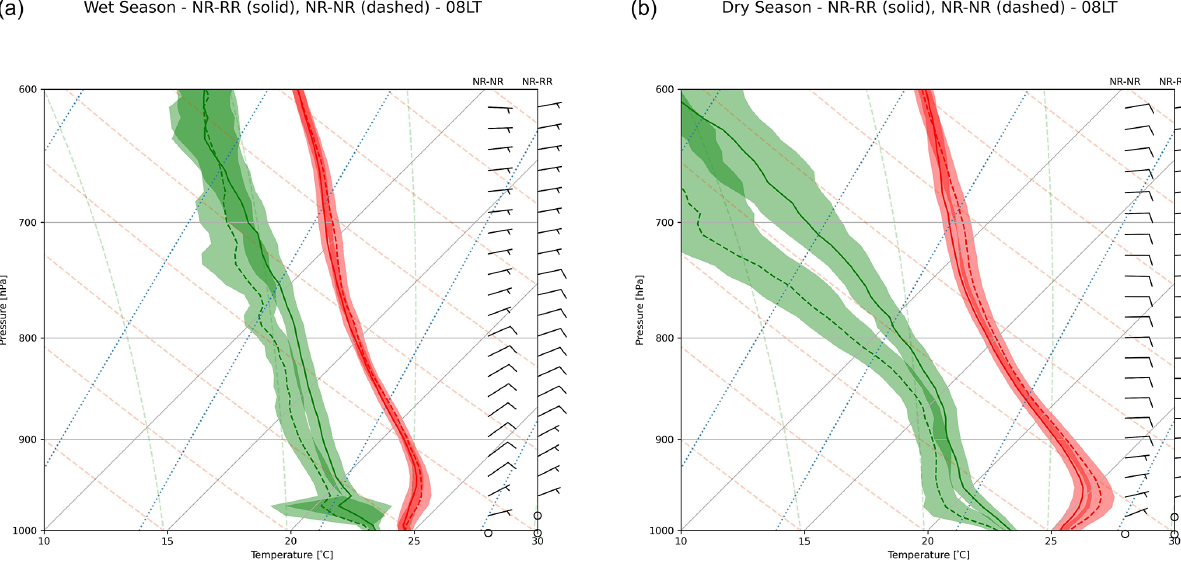
Figure 5. Same as Fig. 4 but for the 08:00LT